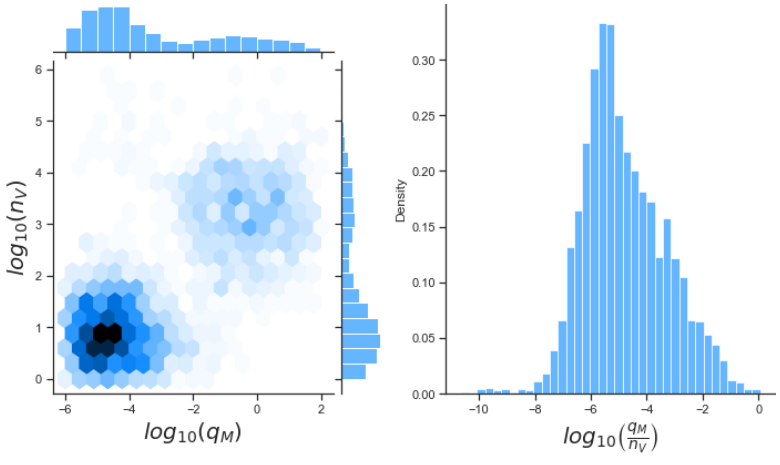
( q ) and log ( n ) showing a positive correla- M V 10 10